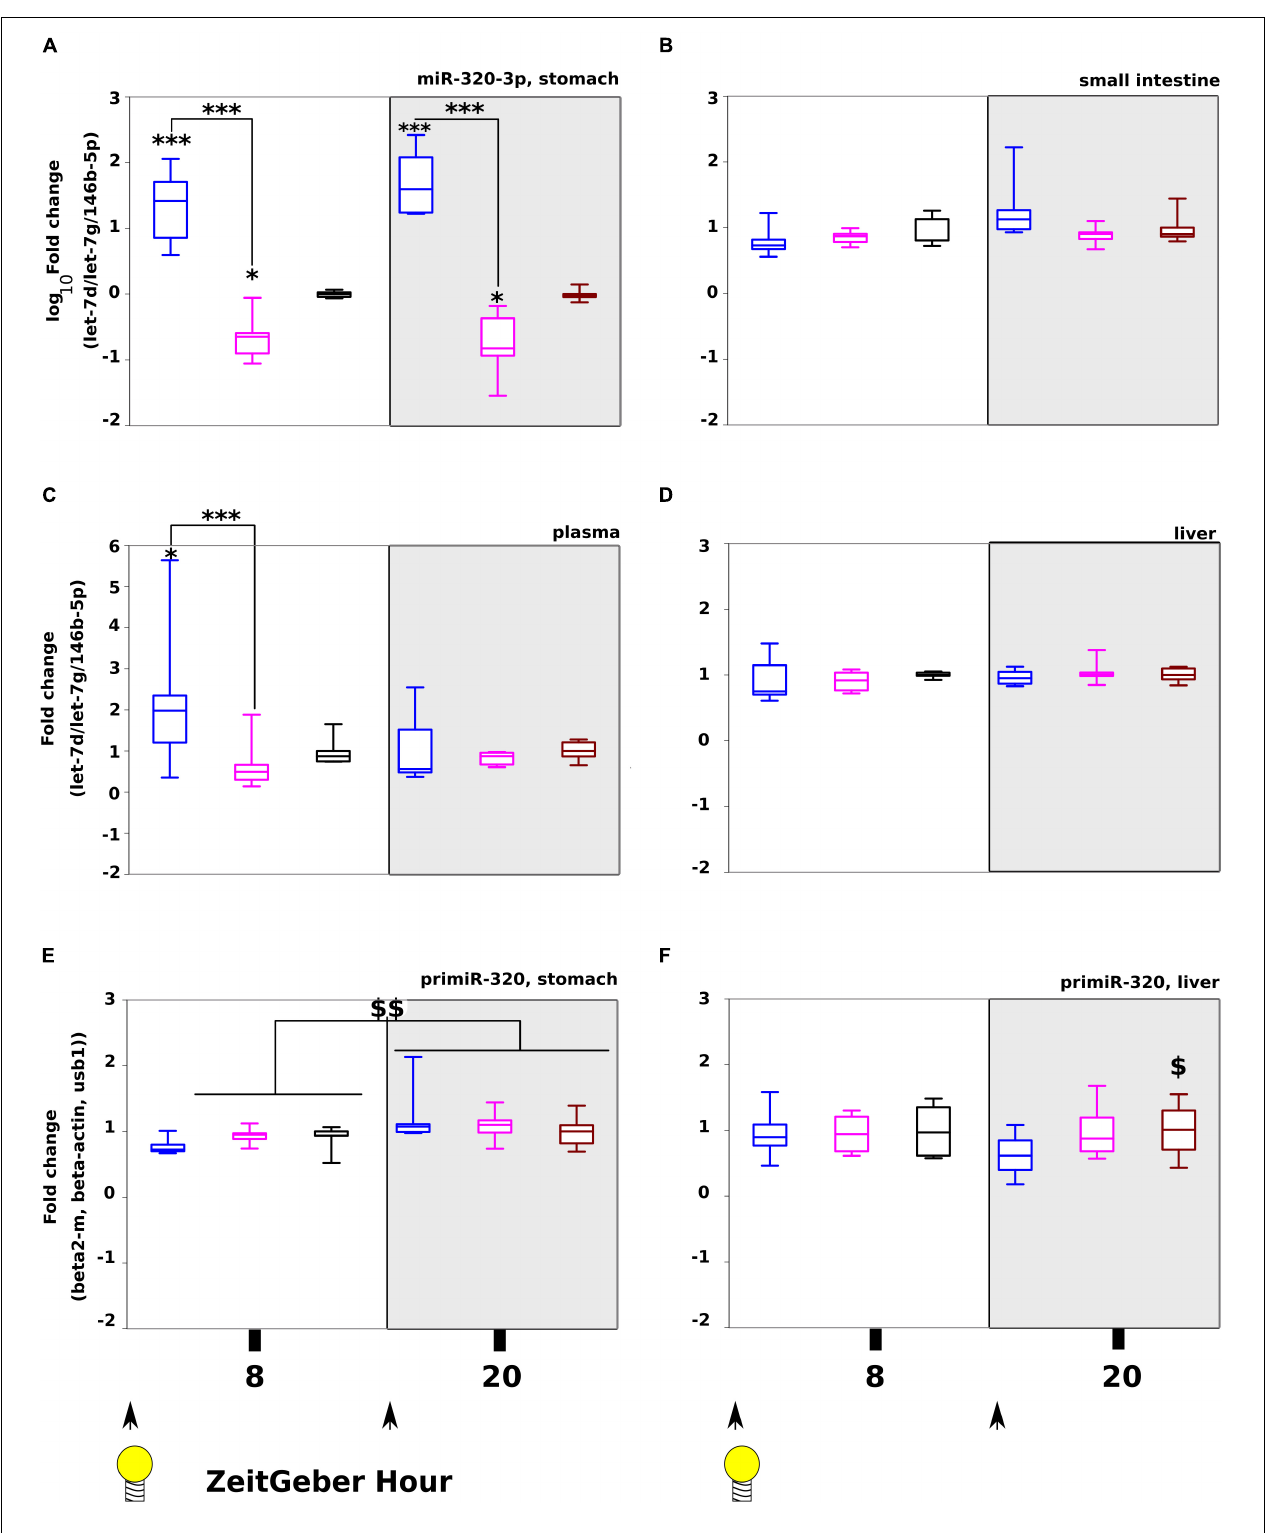
FIGURE 3 | Tracking miR-320-3p in rat pup organs after loading at light on (ZT-8 H) or off (ZT-20 H). Levels of miR-320-3p in the stomach (A) , small intestine (B) , plasma (C) , or liver (D) according to a bolus with mir-320-3p (blue box border), antagomiR-320-3p (magenta) and control (black). In parallel, the levels of primir-320 in the stomach (E) and the liver (F) were determined. We have found highly significant loading of miR-320-3p for both miRNA-supplemented groups in the